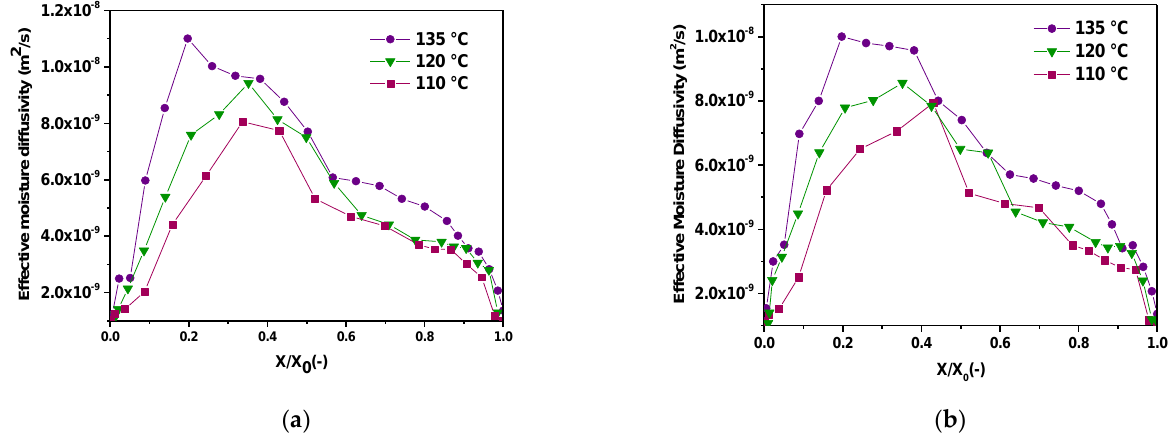
Figure 8. Variation of the effective moisture diffusivity versus the reduced moisture content, ( a ): 1 cm and ( b ): 2 cm.